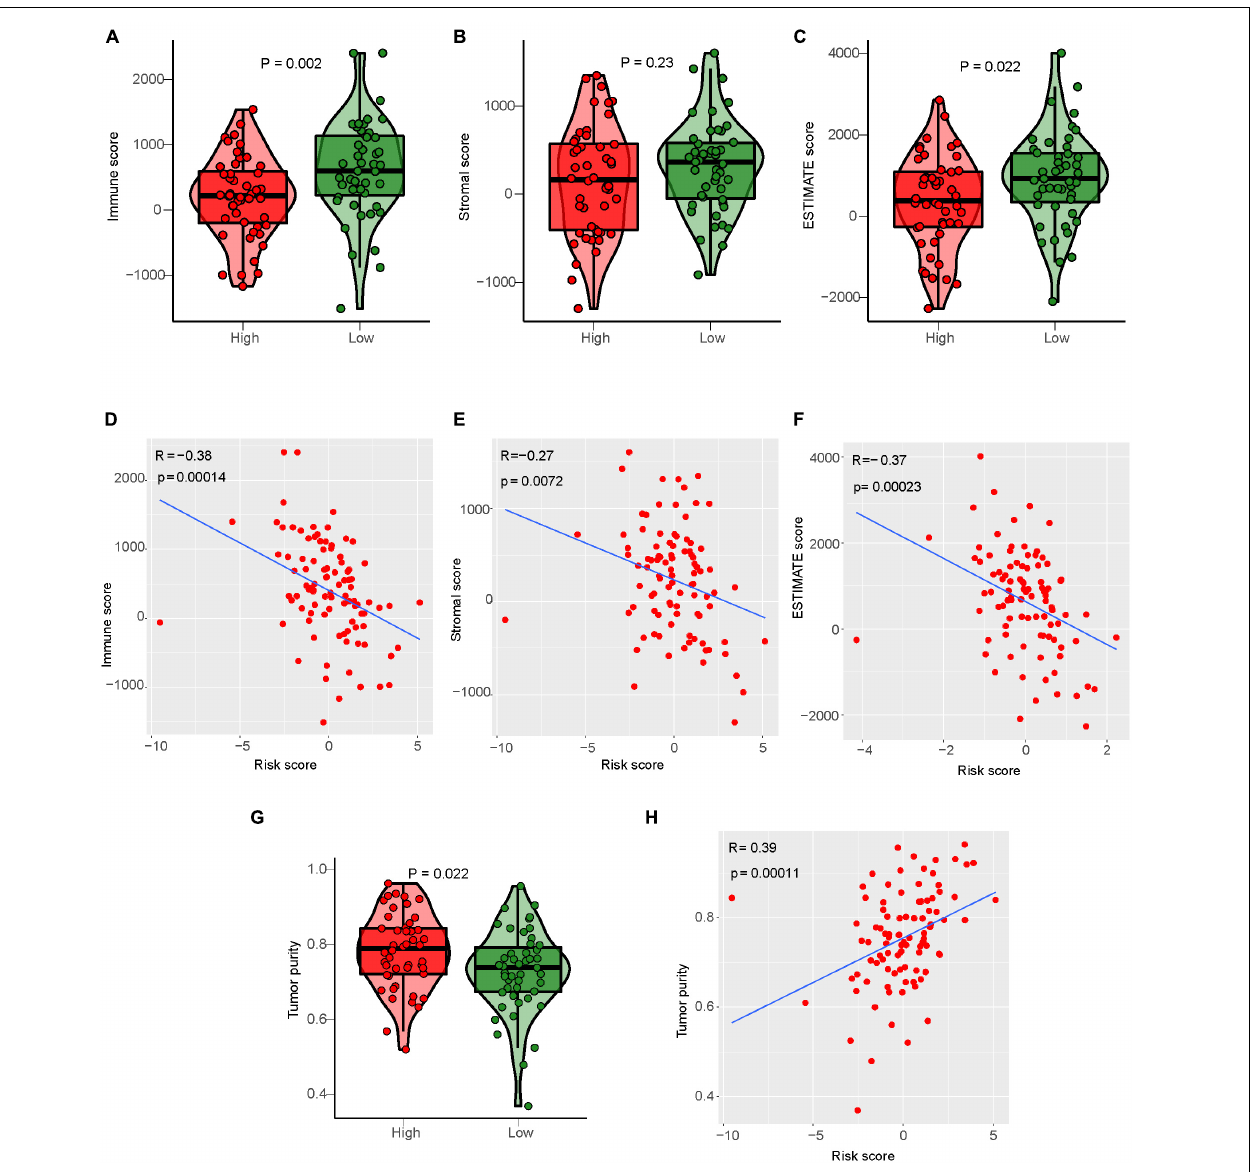
FIGURE 9 | Relationship between IRLs signature and tumor microenvironment score. (A–C) Analysis of differences in the immune score, stromal score, and Estimate score between high-risk and low-risk osteosarcoma. (D–F) Correlation analysis between risk score and osteosarcoma immune score, matrix score, and Estimate score. (G) Analysis of difference in tumor cell purity between high-risk and low-risk osteosarcoma. (H) Correlation analysis between risk score and tumor cell purity of osteosarcoma.